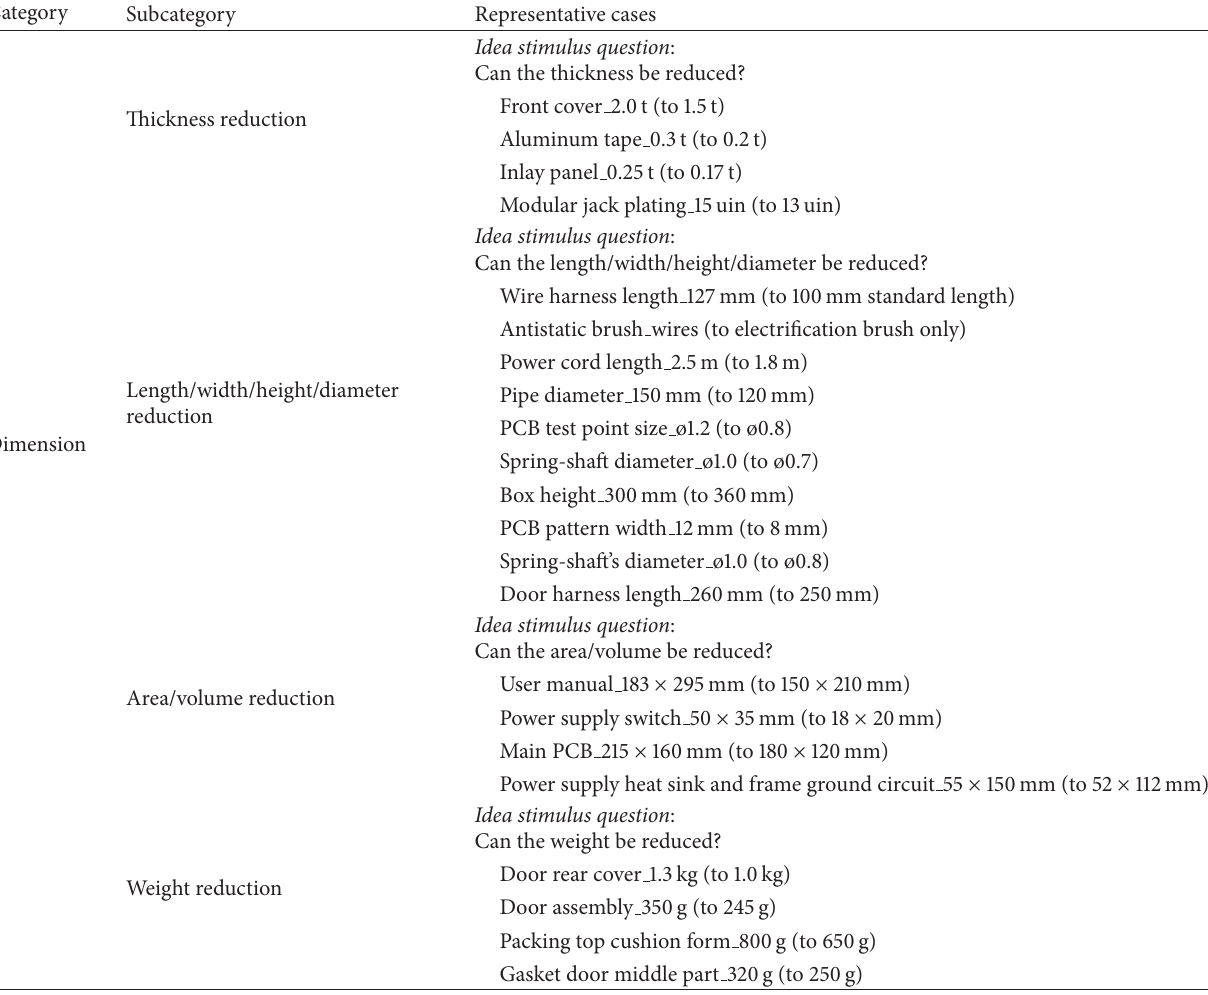
Table 4: Dimension checklist and representative